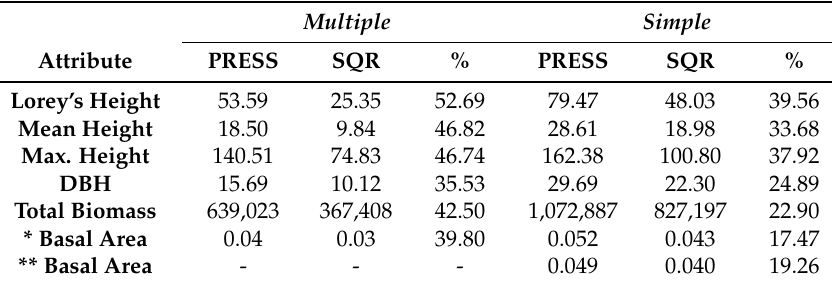
Table 8. PRESS values and SQR difference